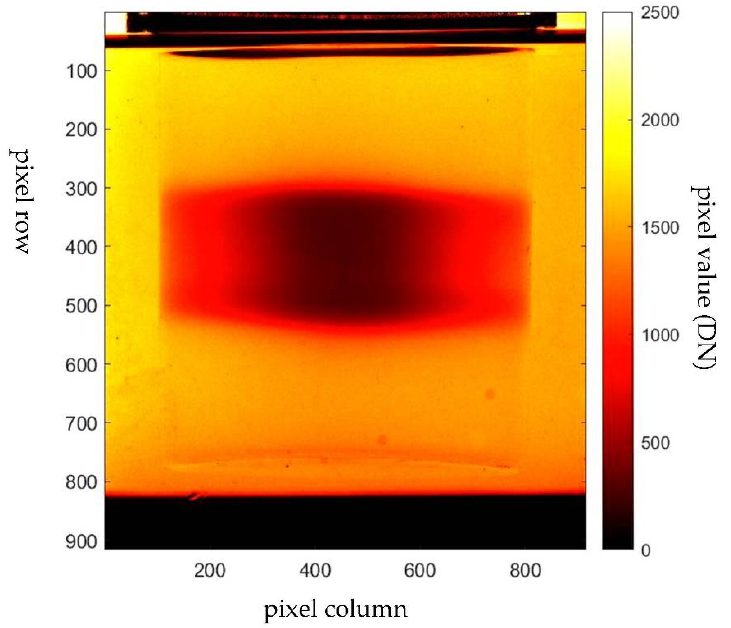
Figure 7. Projection image of PRESAGE irradiated with stereotactic radiosurgery (SRS) treatment. The image was captured with the in-house CMOS-OCT dosimetry system.